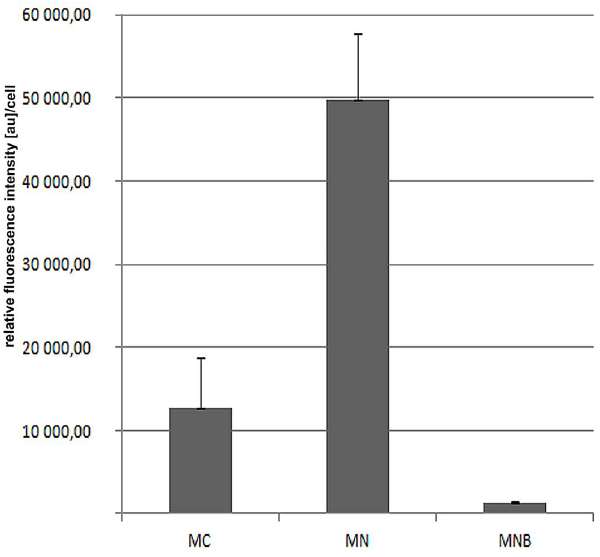
Figure 1. Analysis of the fluorescence intensity resulting from insitu hybridisation of poly(A) RNA in the meristematic cells of lupines roots. There were significant differences in intensity (p , 0.05) between the cytoplasm (MC), nucleus (MN) and nuclear bodies (MNB).